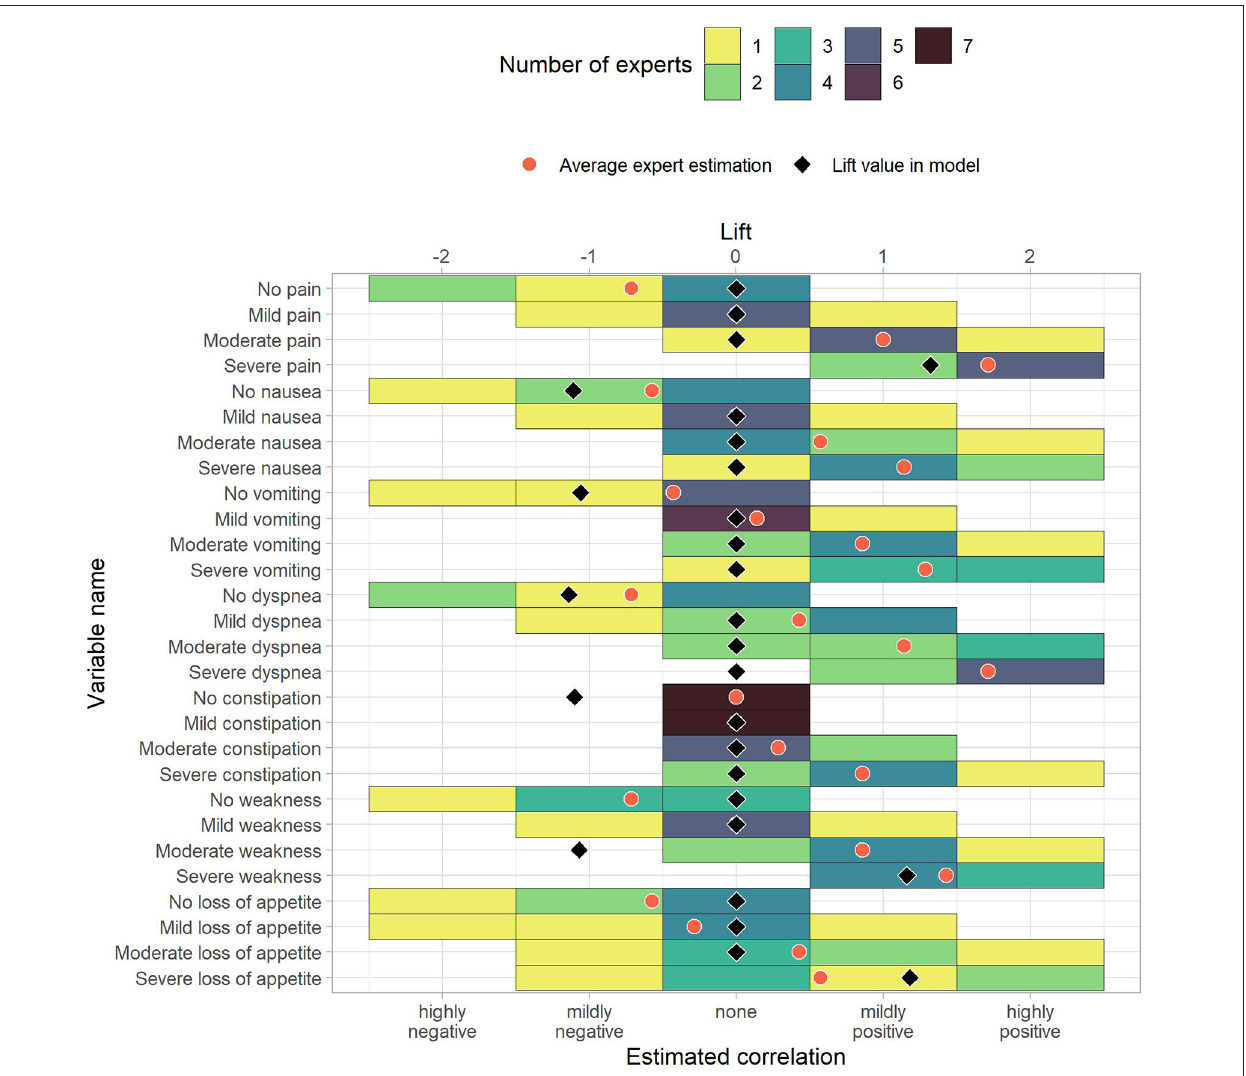
FIGURE 5 | The estimated correlations of HOPE variables to anxiety for the patient’s status (first part). The color indicates how many experts chose the corresponding option. The black diamond indicate the lift value of the corresponding variable in the model, where 0 stands for “not part of the model” and negative values correspond to the lift of no-rules. The red dot is the average expert